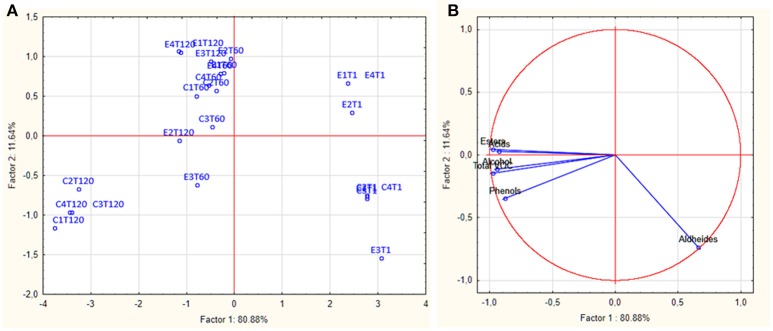
PCA plot (A) and score plot (B) showing the distribution of experimental (E) and control (C) samples through the fermentation process.